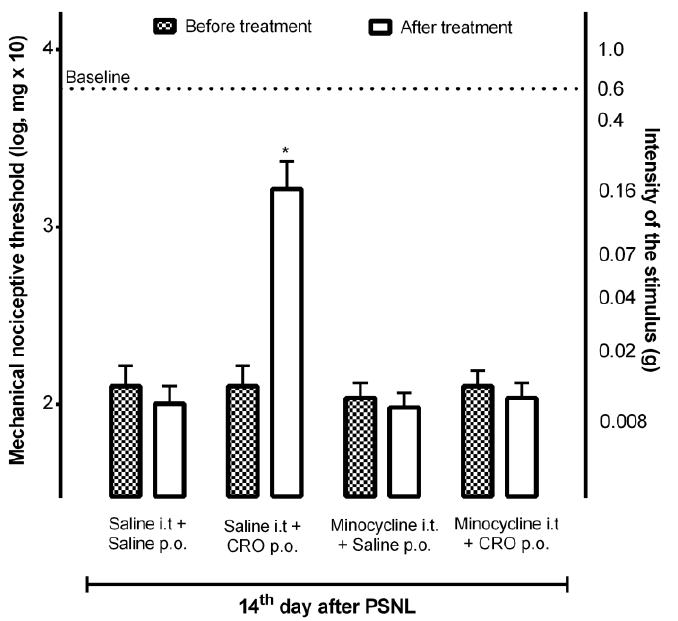
Figure 4. Contribution of microglia to the analgesic effect of crotalphine. Mice that underwent the partial sciatic nerve injury (PSNL) surgery, on the 14th day after surgery, were treated with minocycline i.t. and/or crotalphine (CRO) p.o. The nociceptive threshold was assessed using von Frey filaments. The results represent the group mean ( ± SEM). n = 5–6. * p < 0.05 indicates a statistically significant difference in relation to the PSNL + Saline i.t. + Saline p.o. The two-way ANOVA test was used followed by the Sidak test.